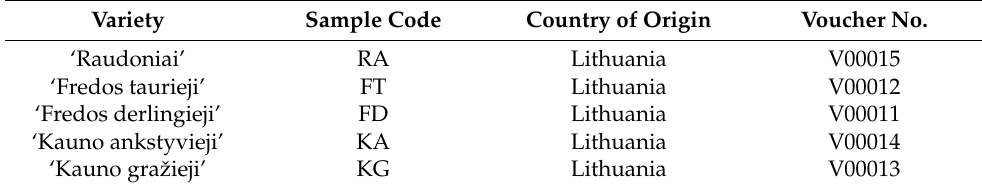
Table 4. Hop varieties analyzed in this study. Variety Sample